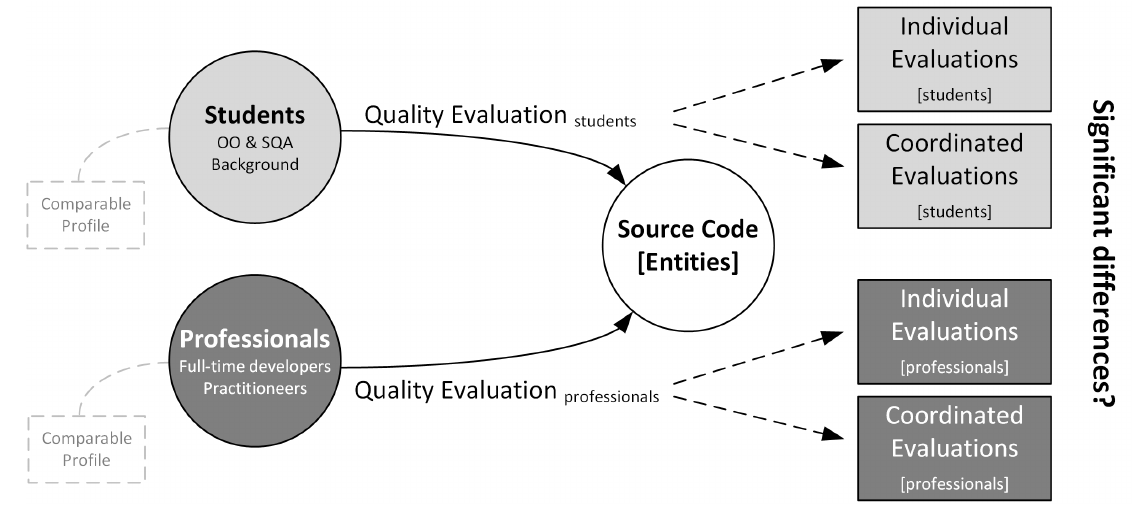
Figure 1. Bird-eye view on the implemented